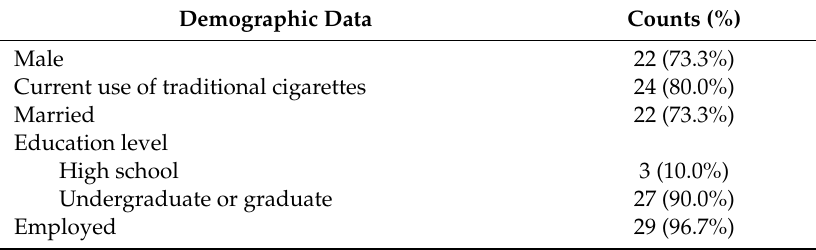
Table 1. Demographic and cigarette use characteristics of study participants ( n =